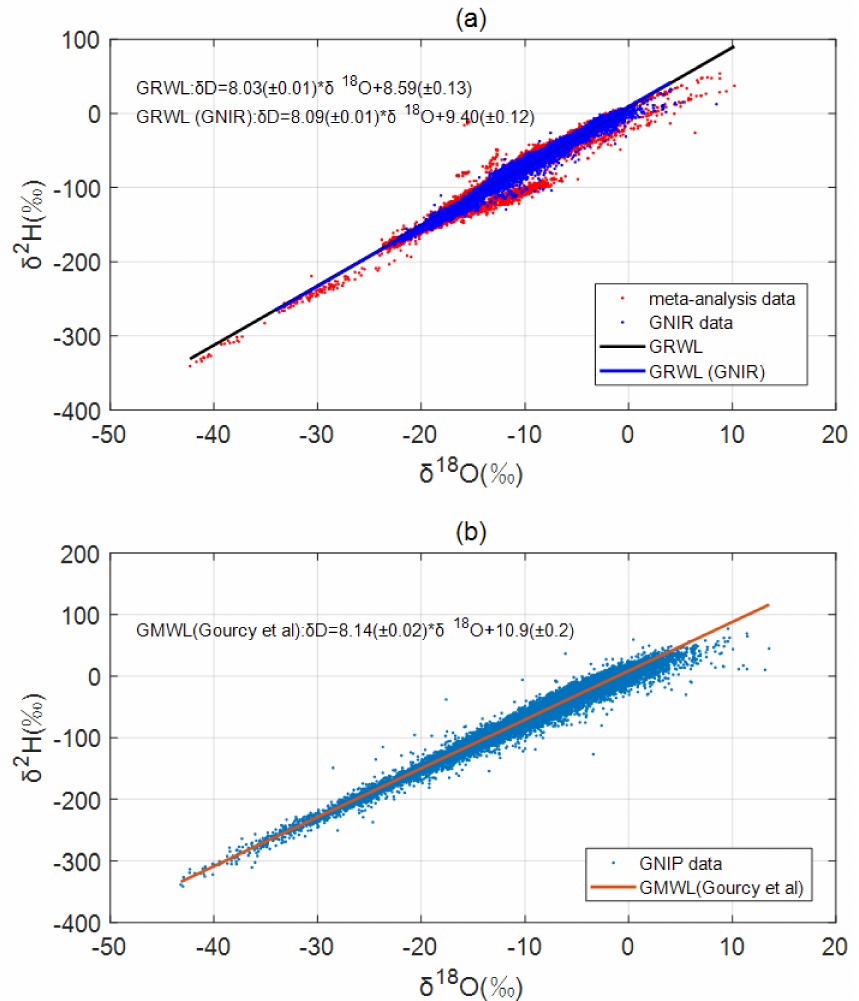
Figure 5. Relationship between δ 18 O and δ 2 H in river water ( a ) and precipitation ( b ) Points in red and blue in ( a ) represent meta-analysis data and original GNIR data,